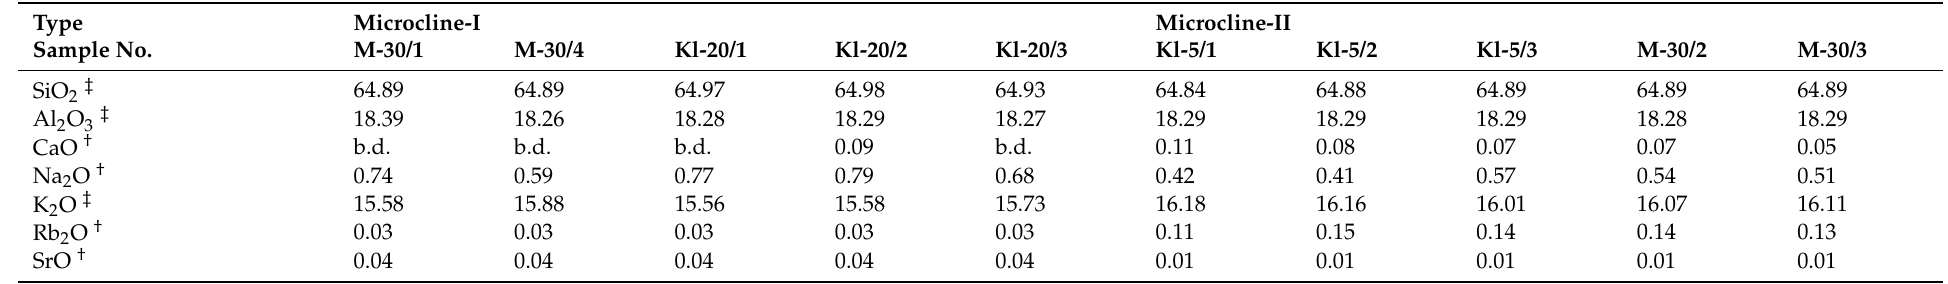
Table 3. Representative chemical composition (wt.%) and mineral formulae (apfu) of K-feldspar from the feldspar pegmatites determined by electron microprobe